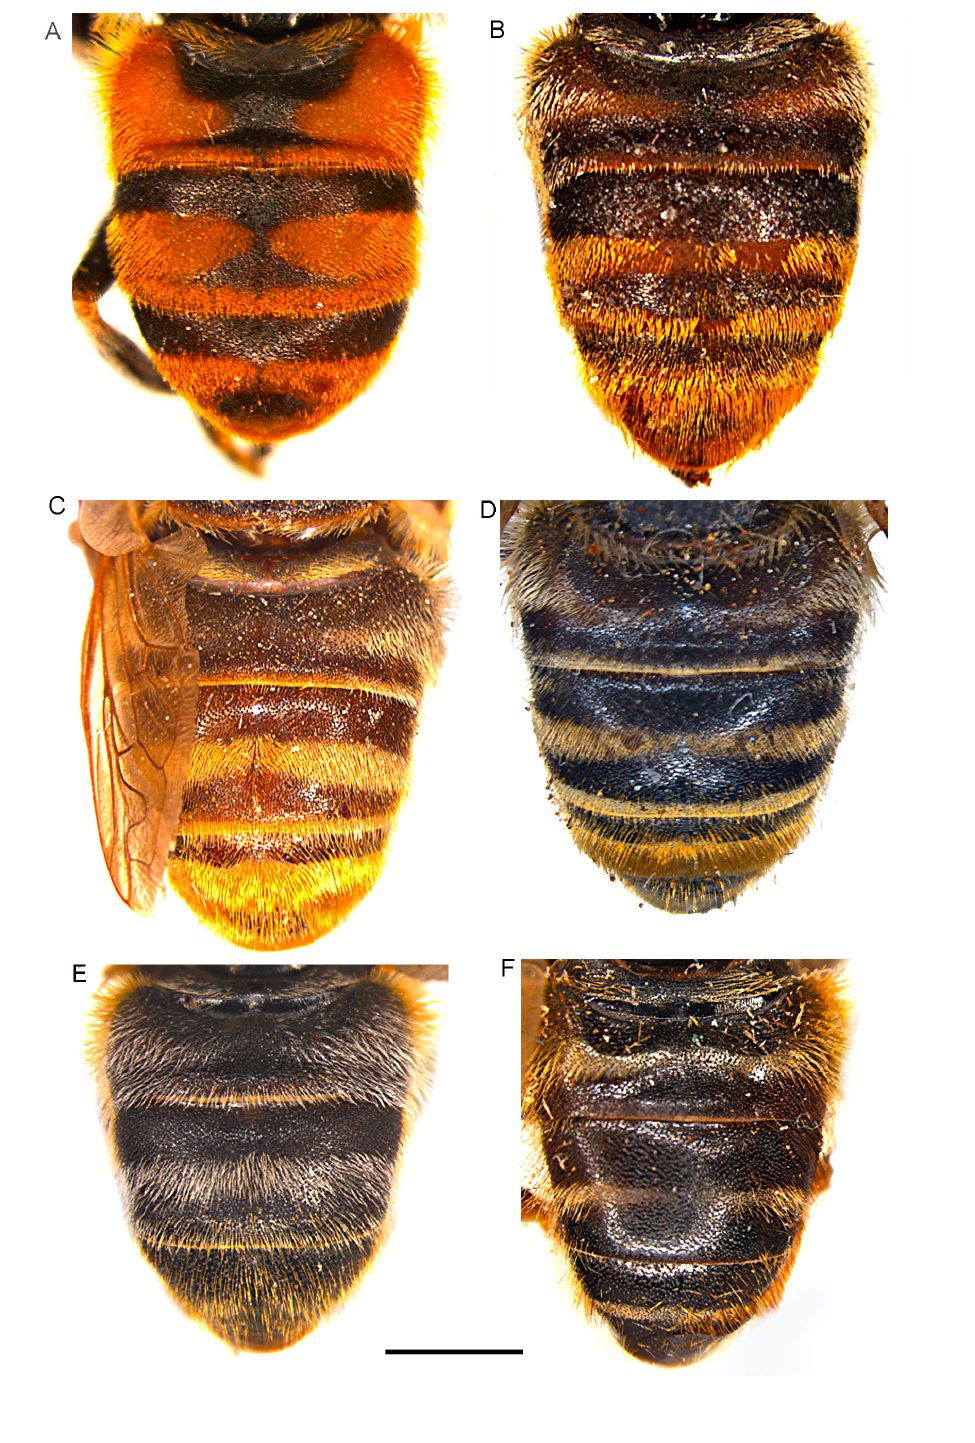
Fig. 5. Male abdomen, dorsal view. A . Merodon bombiformis Hull, 1944 (FSUNS; FSUNS ZA2_079). B . M. multifasciatus Curran, 1939 (USNM 2052372; FSUNS ID 04512). C . M. vittatus Vujić & Likov sp. nov. holotype (NBCN; FSUNS ID 04085). D . M. zebra Vujić & Radenković sp. nov. holotype (RMCA; FSUNS ID 25089). E . M. lotus Vujić & Radenković sp. nov., paratype (FSUNS; FSUNS ID ZA6_066). F . M. nasicus Bezzi, 1915 (RBINS; FSUNS ID 21976). Scale bar = 2